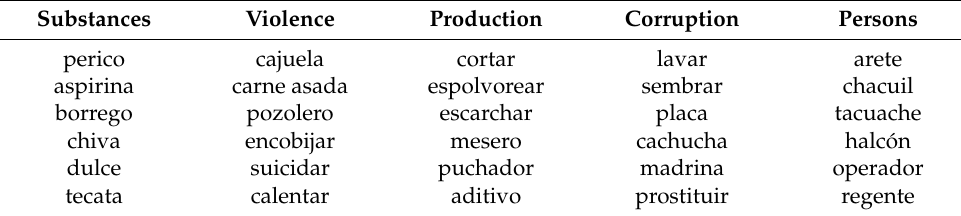
Table 3. Categories for narco-related